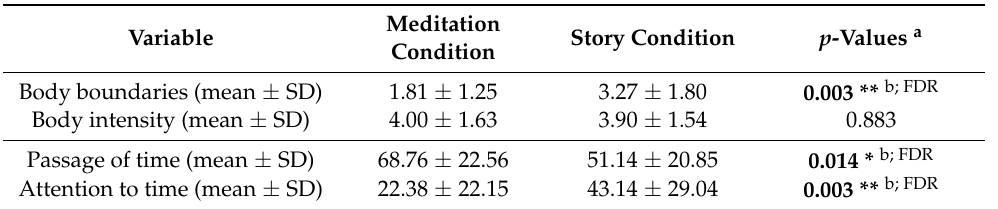
Table 5. Descriptive statistics and independent t -test significance between conditions for body and time scales. a t-Test if not otherwise indicated: * p < 0.05, ** p < 0.01, marked in bold ; FDR significant